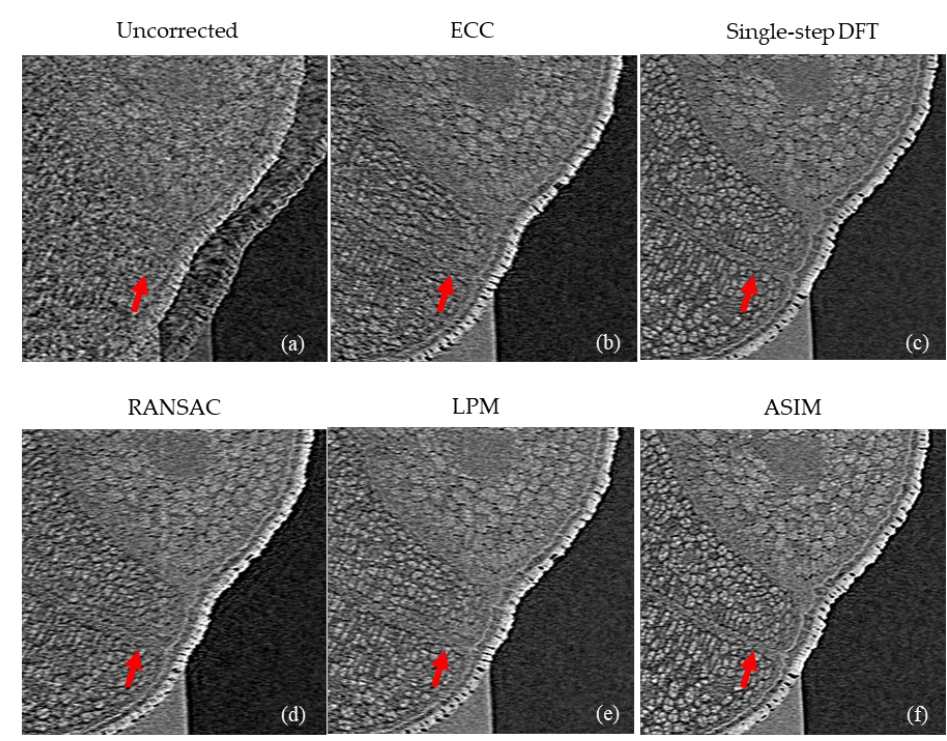
Figure 9. Correction results of difference alignment methods for cabbage seed. ( a ) Uncorrected. ( b ) ECC. ( c ) Sigle-step DFT. ( d ) RANSAC. ( e ) LPM. ( f ) ASIM.